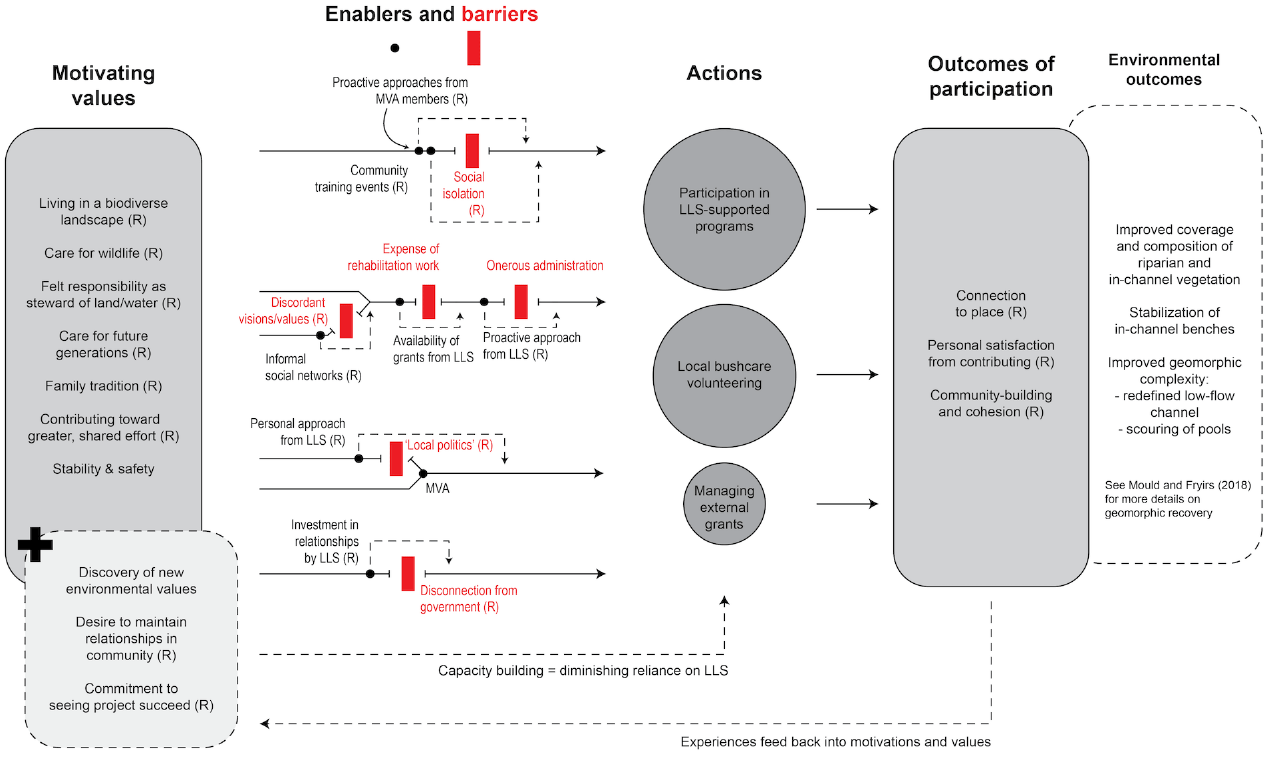
Fig. 3 . The process by which landholders’ motivating values are translated into direct participation in river management (actions) via enablers in the middle-ground. Enablers help to overcome barriers to participation. Direct participation in rehabilitation has personal and social outcomes, which may result in evolution of motivating values. New motivations further drive ongoing participation, and participation may rely less on support from middle-ground agencies as individual and community capacity builds. Dashed lines indicate possible pathways to participation enabled by named factors. Size of “bubbles” in “actions” indicates relative rate of participation in each action. “(R)” indicates a relational factor, e.g., relational value, enabler, barrier, or outcome. MVA = Macdonald Valley Association; LLS = Local Land